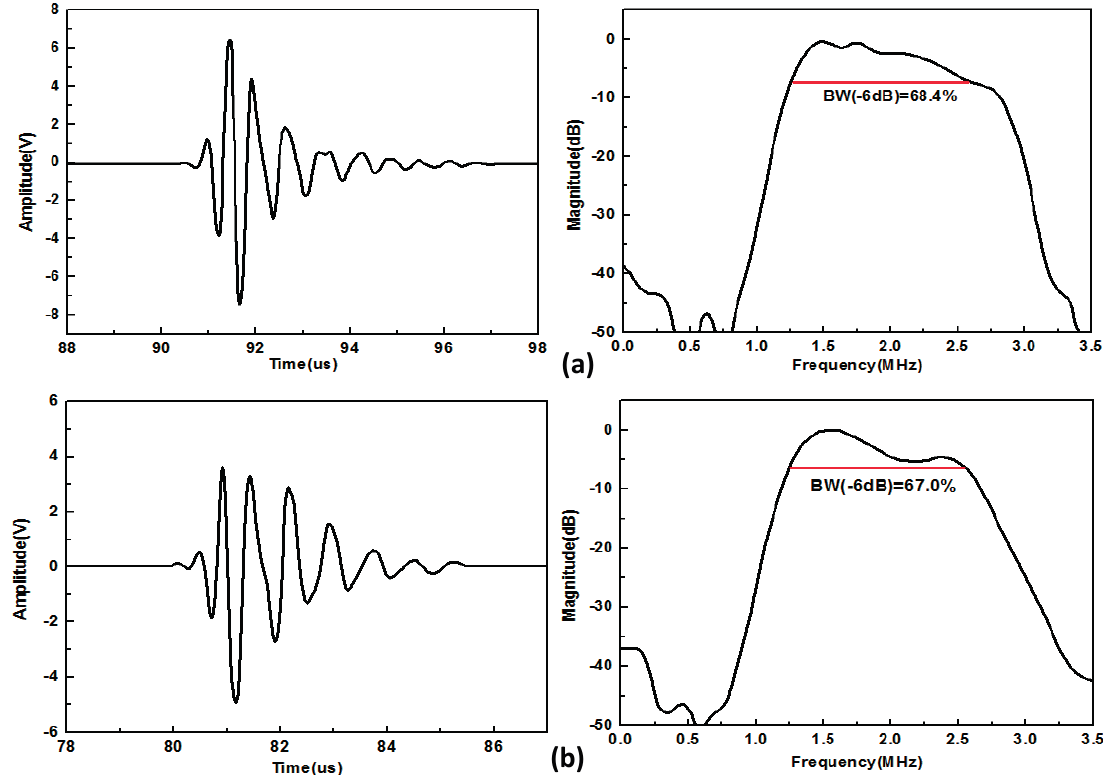
Figure 4. The measured pulse-echo response and frequency spectrum of ( a ) PMN-PT-based TCD transducer and ( b ) commercial TCD